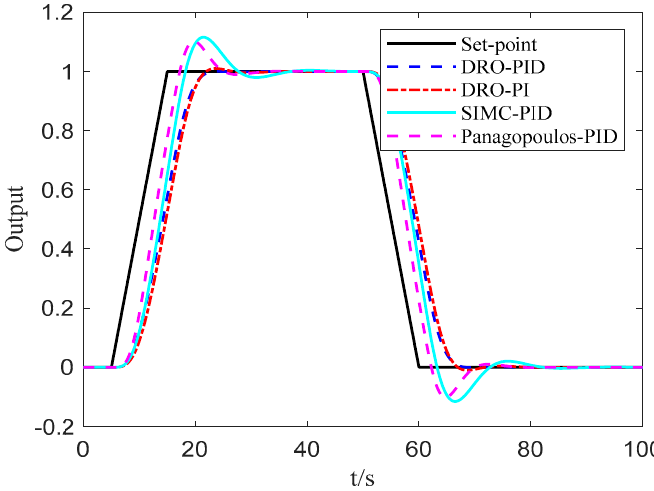
Figure 7. The output response of the ramp input for Example 1.